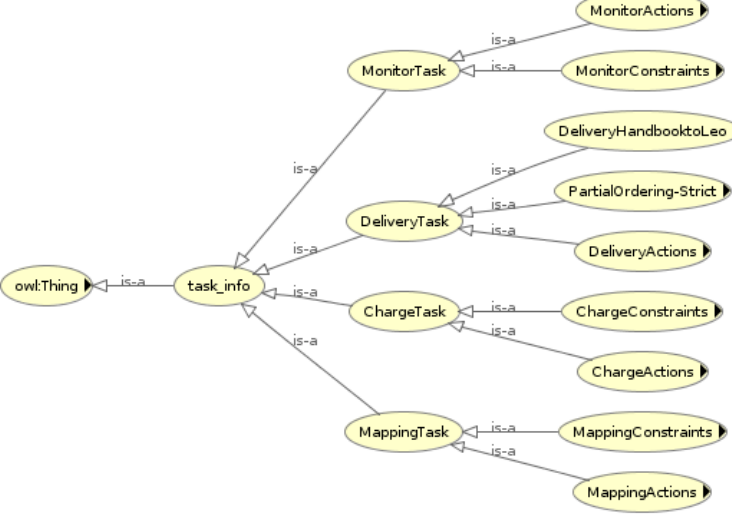
Figure 7. The task ontology shown in Protégé.